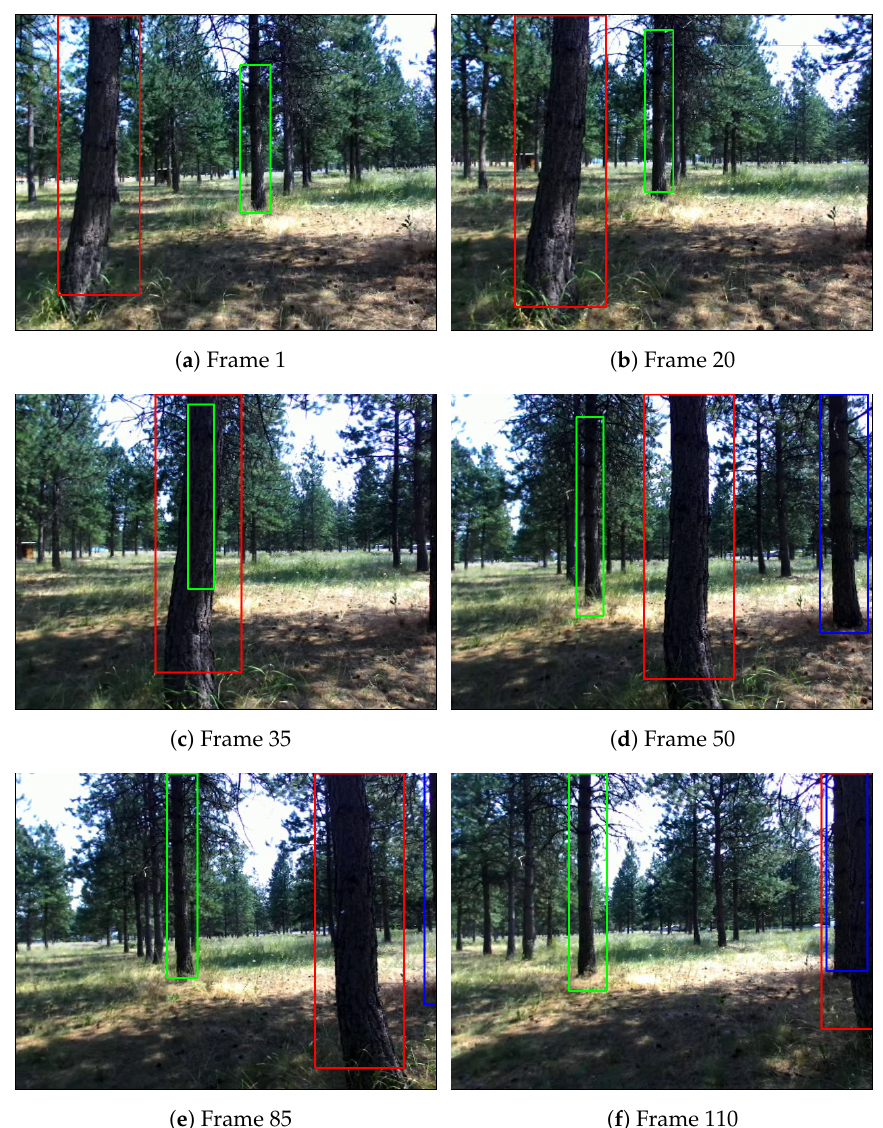
Figure 5. Selected frames from a video sequence in which tree stems are tracked. The colors of the bounding boxes indicate the stem’s